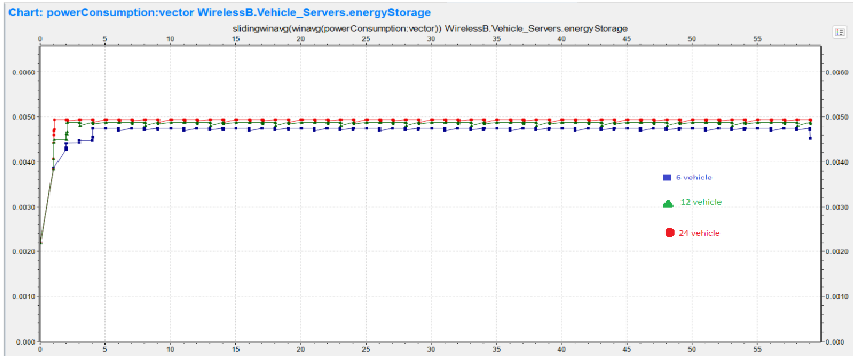
Figure 22. The power consumption for 6, 12 and 24 vehicles.